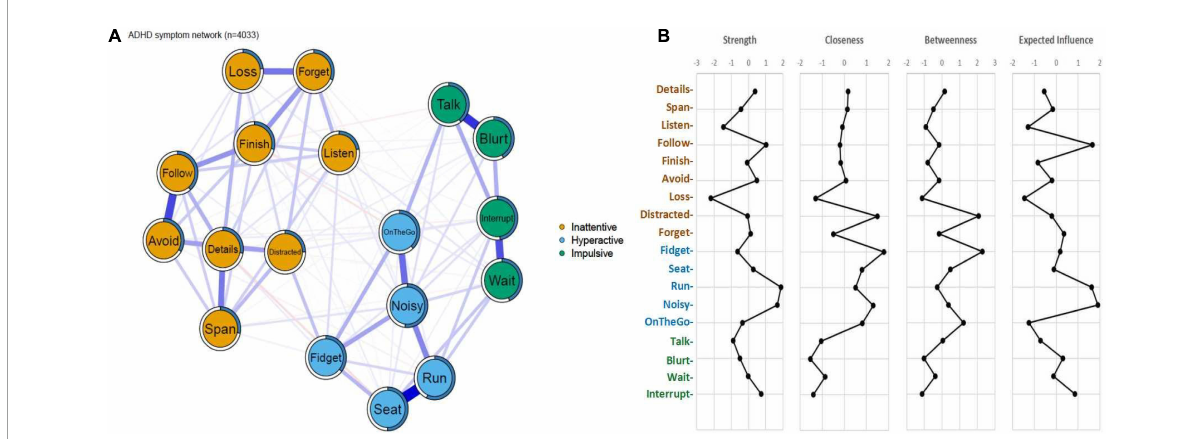
FIGURE1 (A) Symptom network of ADHD core symptoms. The blue edges indicate positive partial correlations and edges in red indicates negative partial correlations. Thicker lines represent stronger connections. The blue ring around each node represents its predictability values. (B) Centrality indices and Expected Influence of the symptom network in ADHD. Standardized z-scores of strengths, closeness, betweenness and expected influence for each node in the network were plotted.